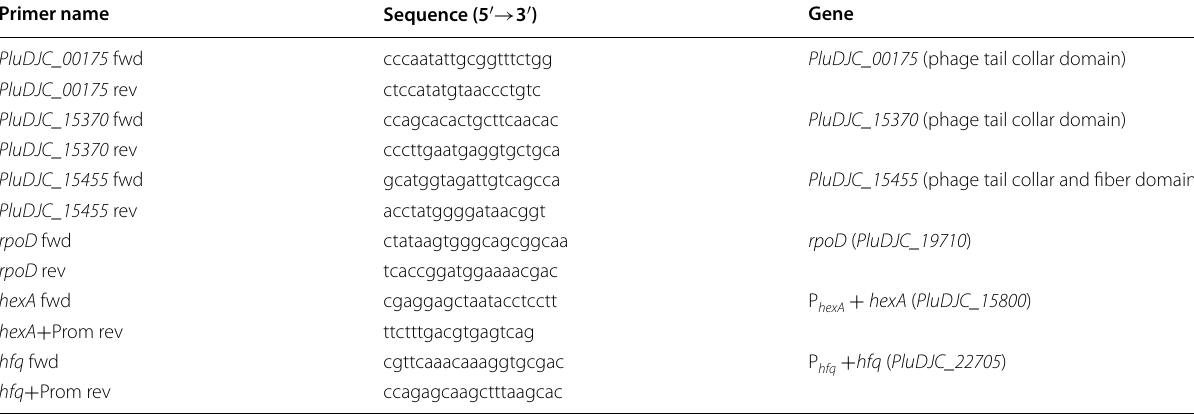
Table 2 Primers used for amplification of the respective genes carrying point mutations identified by HTS analysis. Primers were used for the gene amplification and further